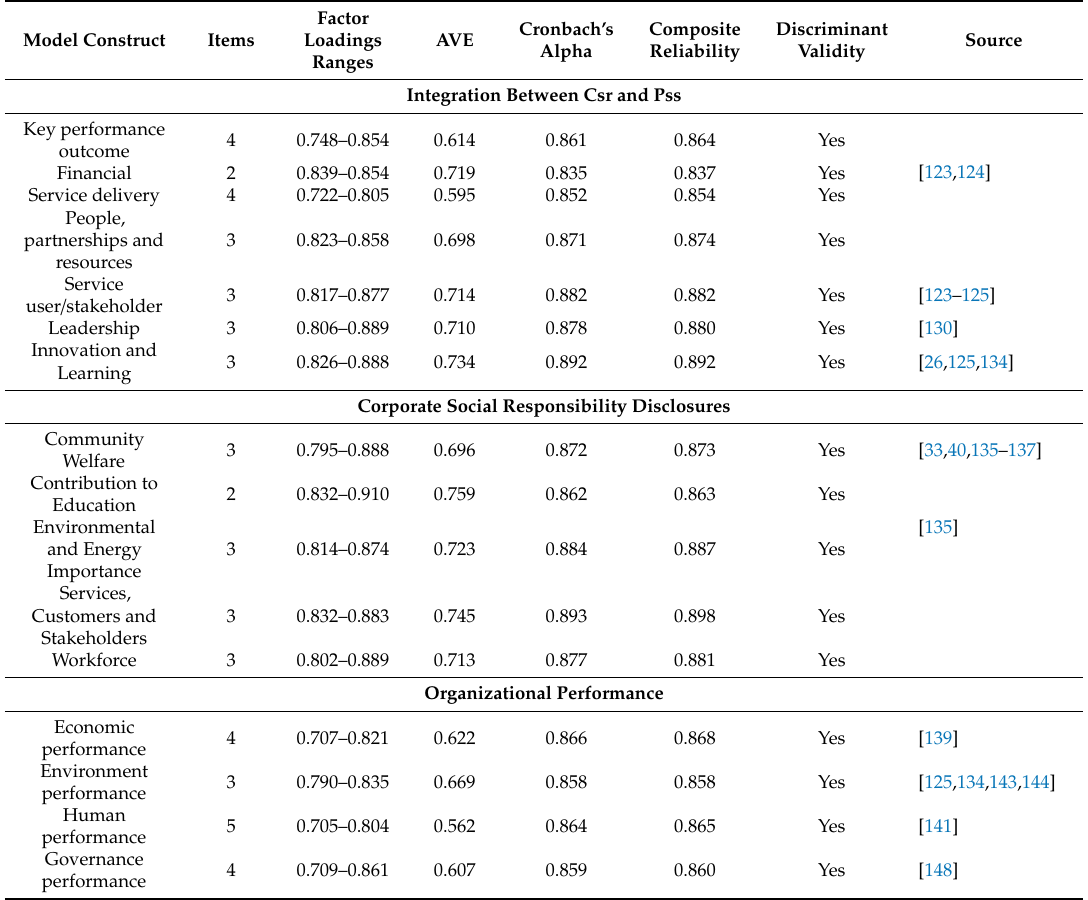
Table 1. Results summary for the measurement